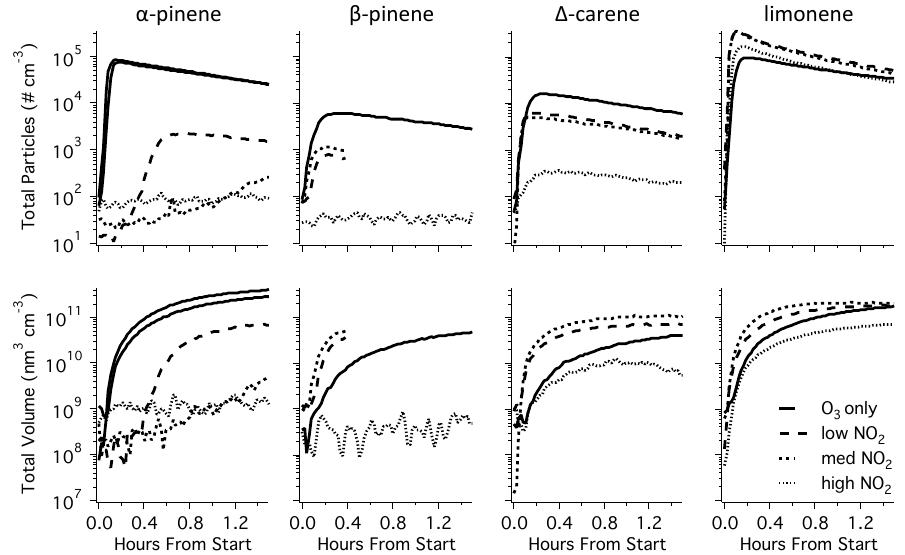
Figure 3. Raw total number concentrations ( N tot ) and total volume concentrations ( V tot ) at each NO 2 concentration for each monoterpene studied, not corrected for wall